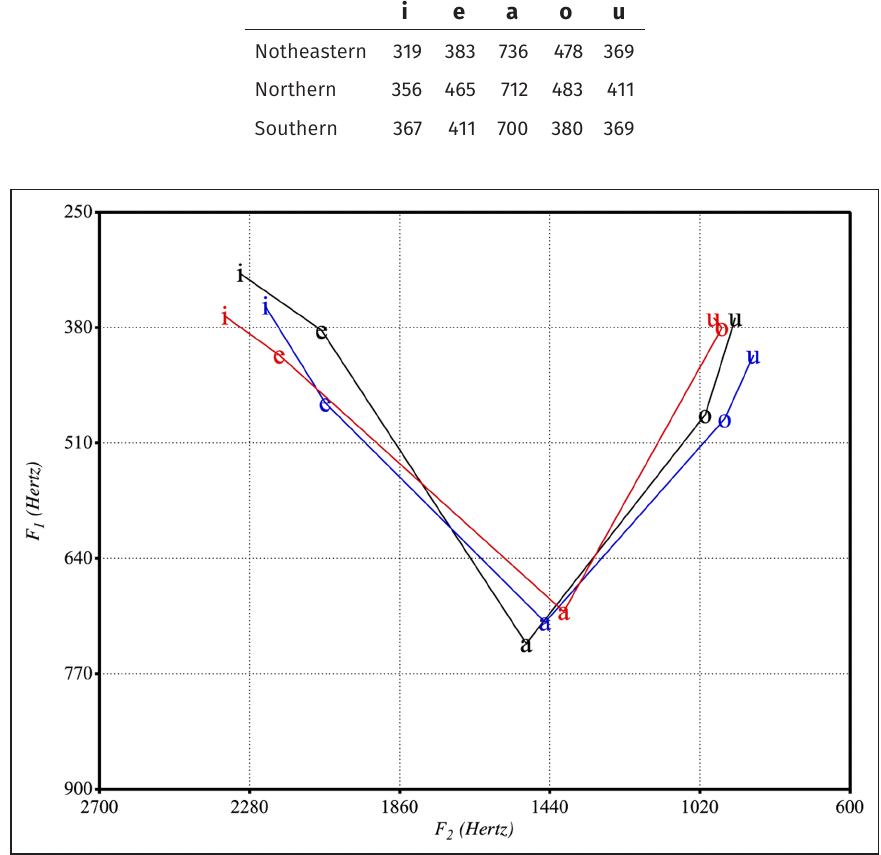
Table 5: F1 geometric means (in Hz) of the pretonic vowels in the three dialects.